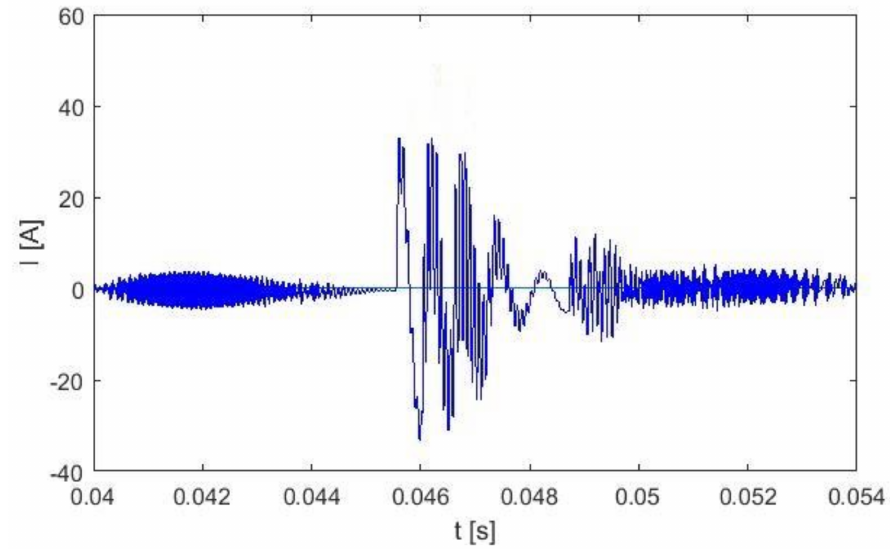
Figure 11. Current waveform between the H-bridge and grid